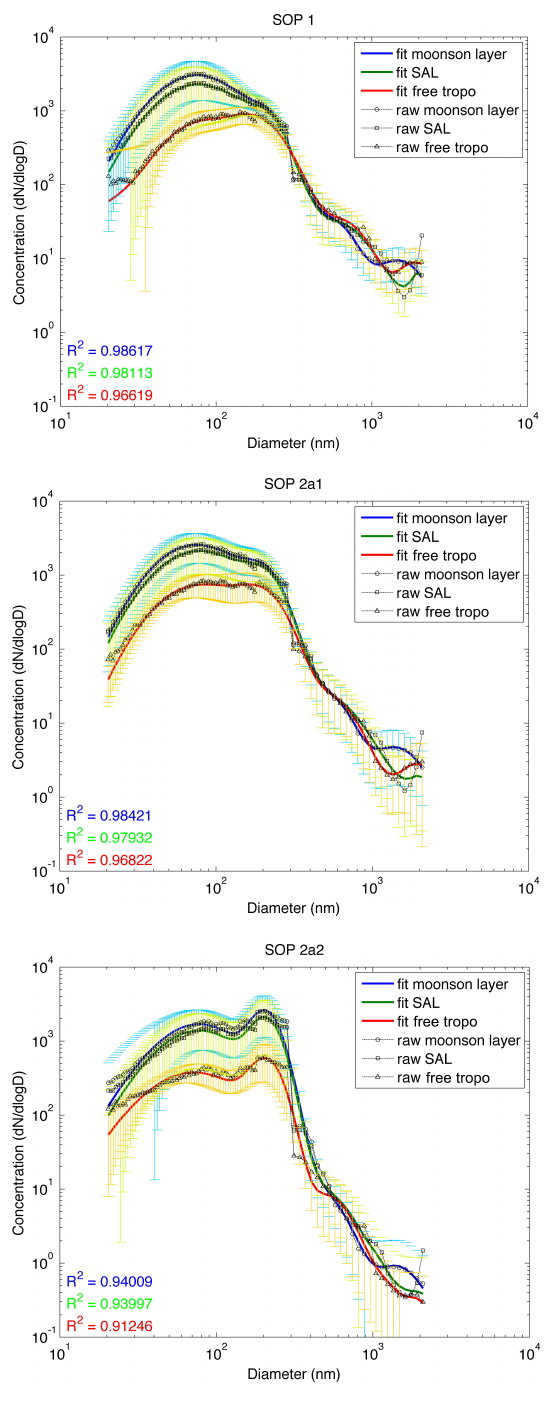
Fig. 4. Mean particle number size distributions observed in the monsoon layer, Saharan air layer (SAL), and free troposphere from vertical exploration of the atmosphere in the vicinity of Niamey dur- ing the three AMMA SOPs corresponding to “dry”, “monsoon on- set” and “high monsoon” periods. Error bars indicate 1 standard deviation. Open legends denote the averaged raw spectra and solid curves are the fitted log-normal size